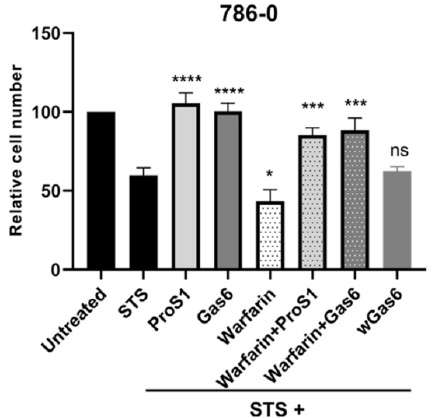
Figure 6. MTS assay showing the influence of vitamin K antagonism by warfarin on growth/viability of 786-0 (ProS1-producing) cells. Apoptosis was induced in 786-0 cells by staurosporine (0.1 µM), and the effects of co-incubation with exogenous TAM ligands over 20 h was measured, both in cells pre-treated or not with warfarin for 48 h. wGas6 is a fully uncarboxylated Gas6 protein used as the negative control for the vitamin K-dependence of the functionality of Gas6. Data are mean±SEM; ANOVA with Tukey’s multiple comparison post-hoc analysis; **** p < 0.0001, *** p < 0.001, * p < 0.05 and ns, not significant, versus staurosporine (STS) (n = three separate experiments).